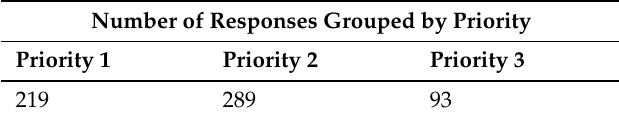
Table A3. The result of the query “Second Resource to Transfer Patients”.